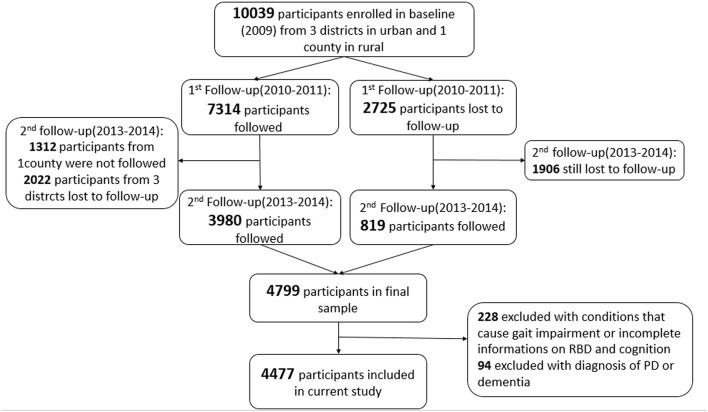
Flowchart of the study.